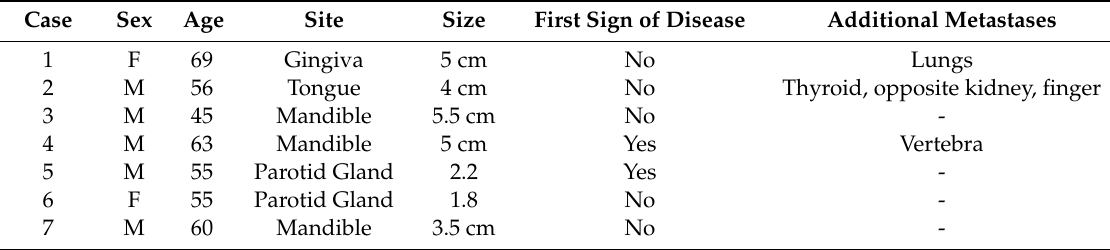
Table 2. Clinico-pathological features of 7 cases of clear cell renal cell carcinoma metastatic to the oro-facial